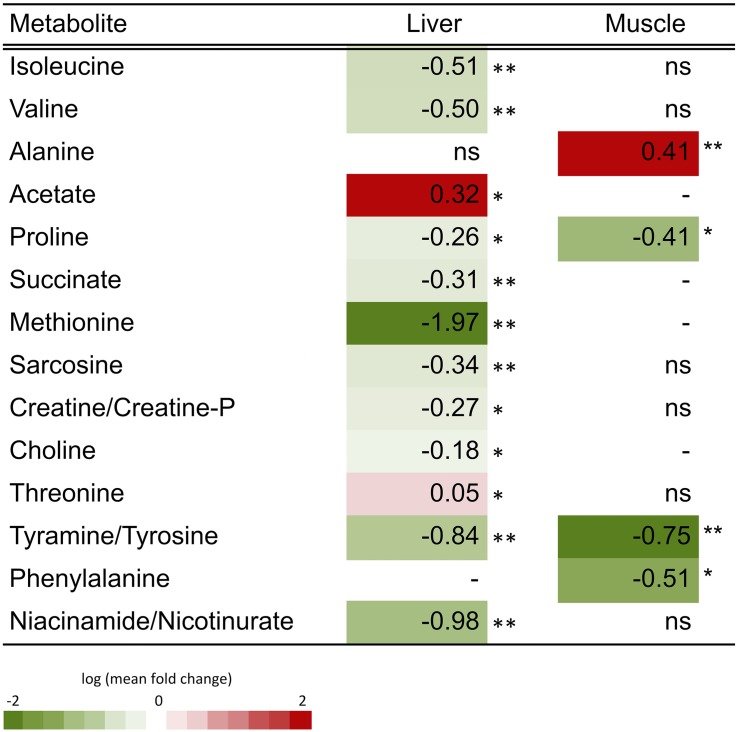
Heatmap of the fold-change variation (log mean FC, mean relative concentration in S group/mean relative concentration in P group) of the metabolites identified in the aqueous fraction of liver and muscle of barramundi (L. calcarifer). Student’s t-test or Mann-Whitney test were applied dependent on the conformity to normal distribution. Detailed information about all metabolites is presented in supplementary information (Supplementary Tables S1, S2). Key: (–) metabolite not identified in the tissue; ns, fold change with non-significant variation; ∗p < 0.05, ∗∗p < 0.01, and ∗∗∗p < 0.001.